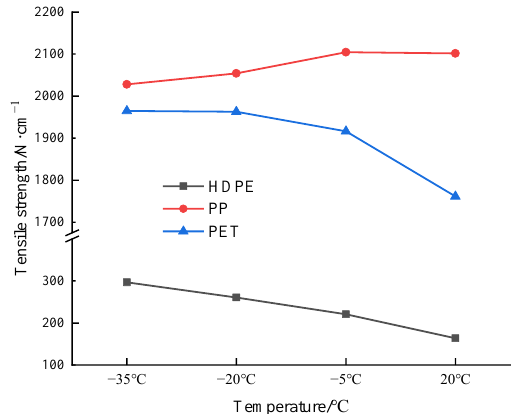
Figure 17 . Tensile strength-temperature curves of the three geocell specimens . Figure 17. Tensile strength-temperature curves of the three geocell